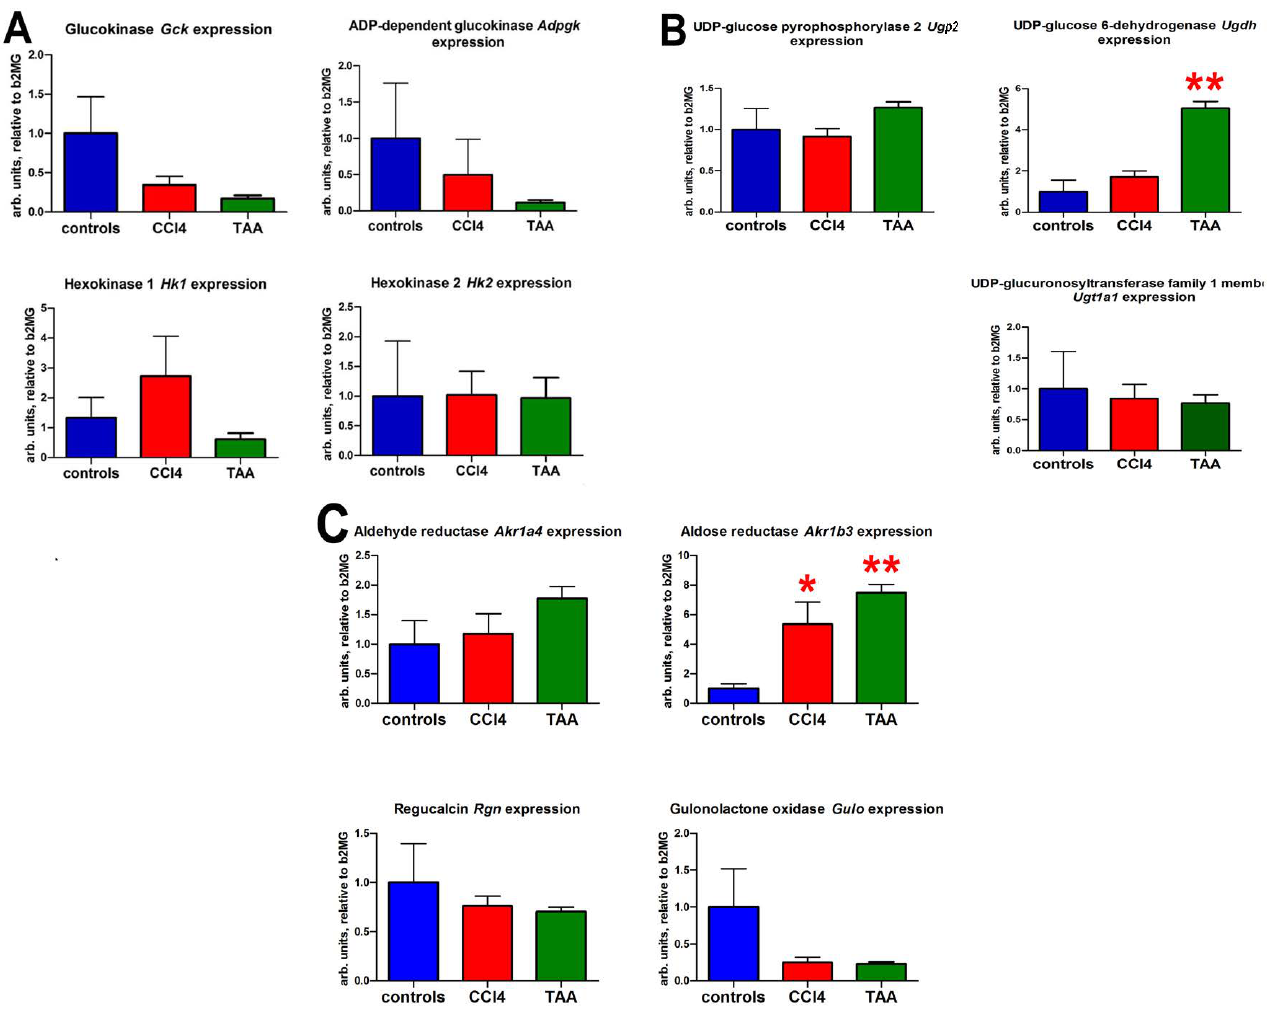
Figure 7. Hepatic expression of mouse genes involved in ascorbic acid synthesis from glucose and galactose after administration of CCl4 or TAA. ( A ). The phosphorylation of hexoses pathway. ( B ). The synthesis of glucuronic acid from glucose 1-phosphate pathway. ( C ). The synthesis of ascorbic acid from glucuronic acid pathway * = p < 0.05 ** = p < 0.01 compared to